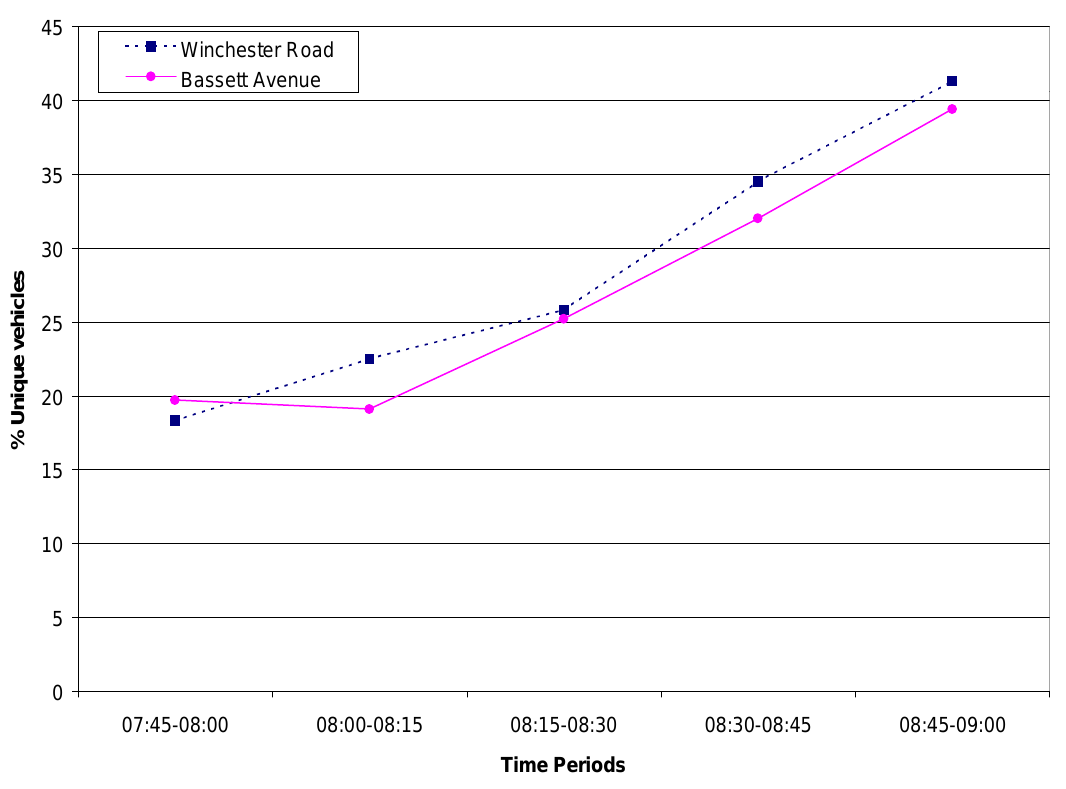
Figure 3. The mean percentage of vehicles from time slices 07:45-08:00, 08:00-08:15, 08:15- 08:30, 08:30-08:45 and 08:45-09:00 which were unique to each day in the 1996